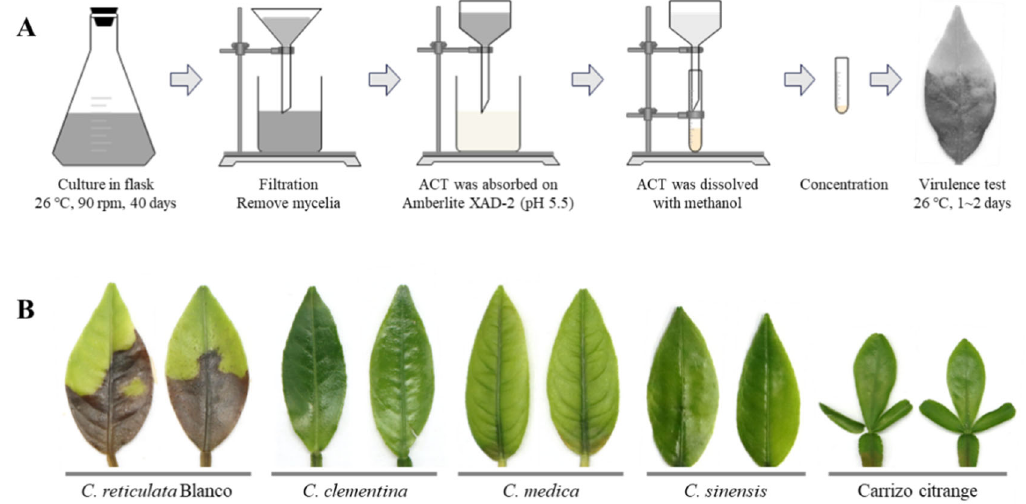
Figure 1. Different citrus accessions display distinct sensitivity to ACT ‐ toxin. ( A ) Isolation procedure to obtain ACT crude extract. ( B ) Virulence test of ACT crude extract on leaves of different citrus accessions.